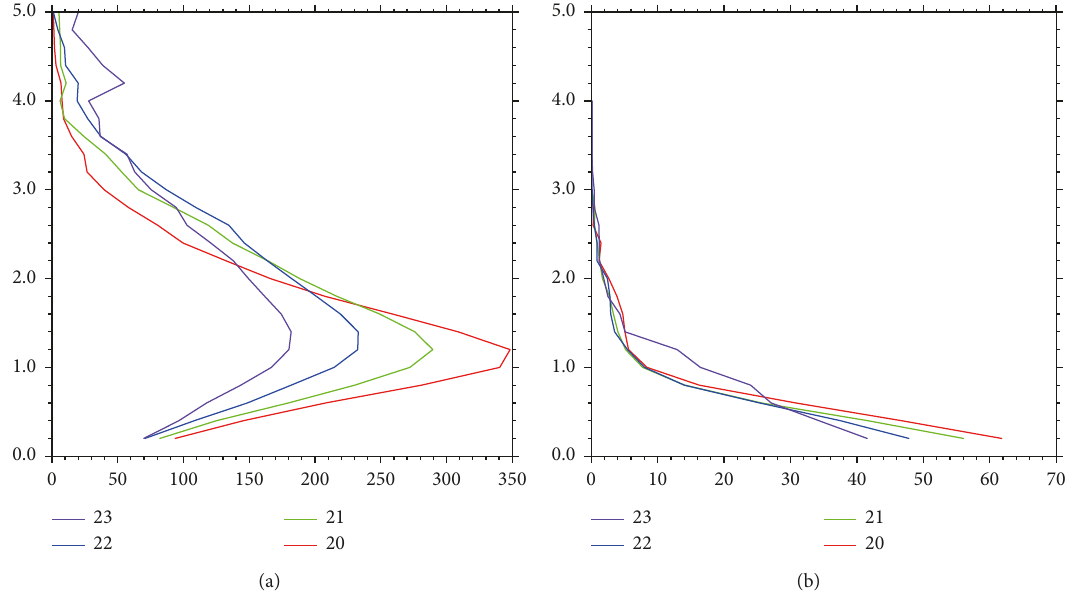
1 ) during 2000-2300 UTC 4 July 2014. kg · −